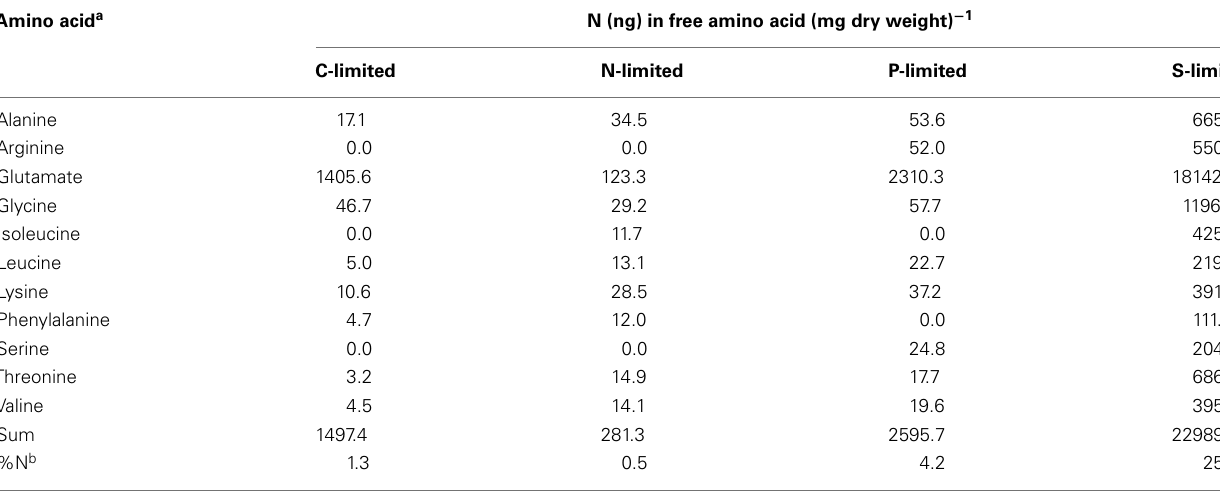
TableA6 | N content in free amino acids measured in steady-state R. pomeroyi DSS-3 cells. Amino acid a